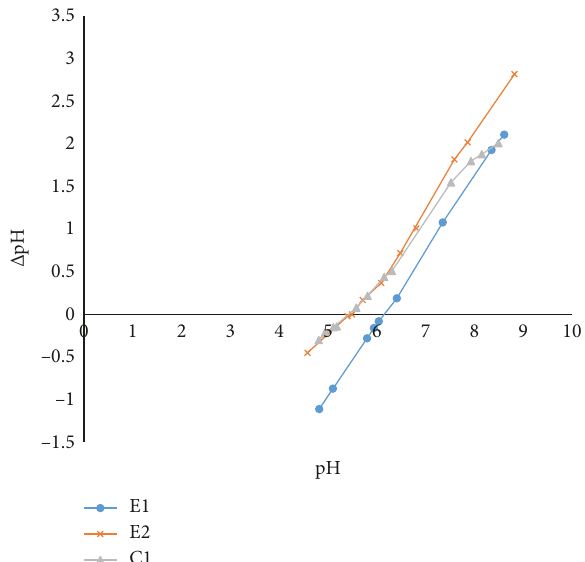
Figure 3: Point of zero charge (pH samples.